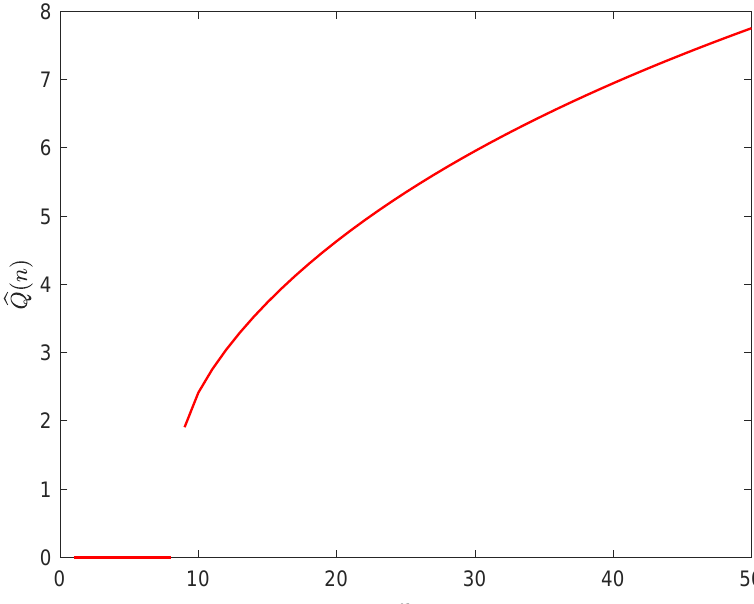
Figure 6. Aggregate Information in Equilibrium When Λ (cid:54) = 1.